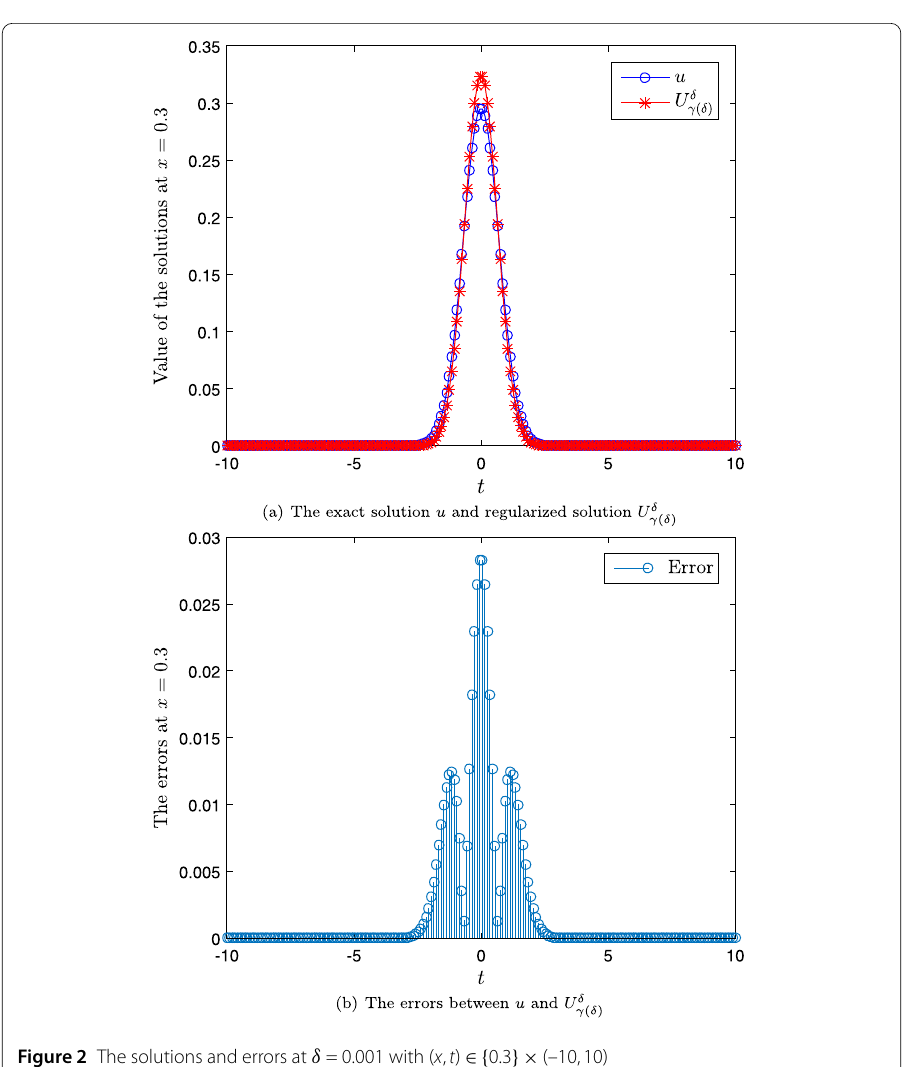
Figure 2 The solutions and errors at δ = 0.001 with ( x , t ) ∈ { 0.3 } ×